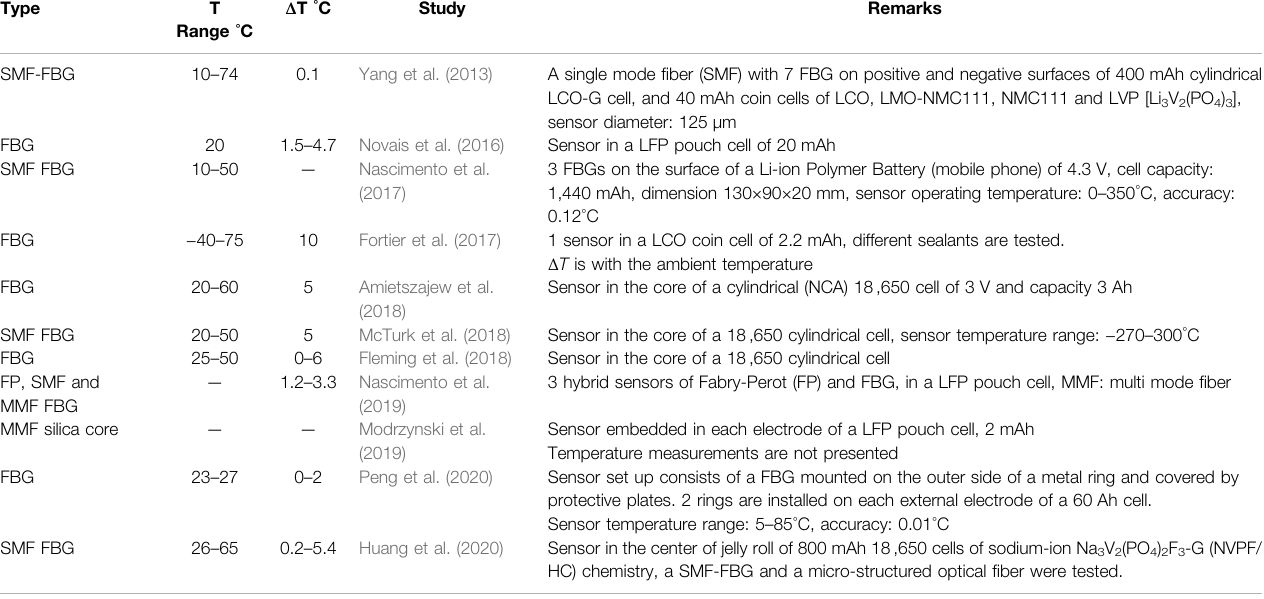
TABLE 3 | Details on optical fi ber sensors used in cells. Type